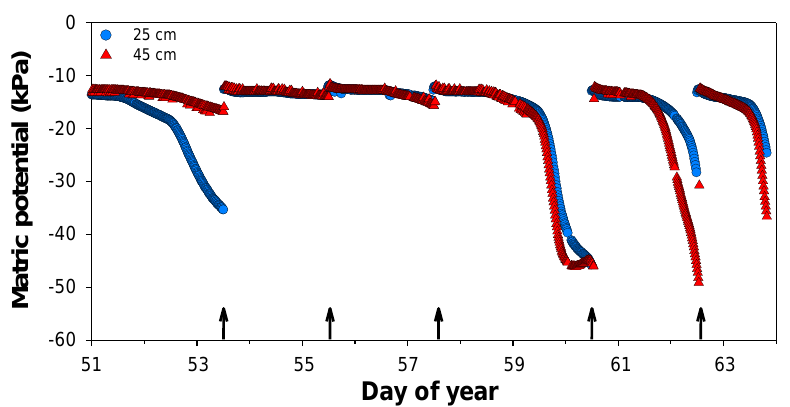
Figure 12. Evolution of matric potential at 25 and 45 cm depth measured by node 04 with MPS-6 sensors (year 2020). The arrows indicate the irrigation events.